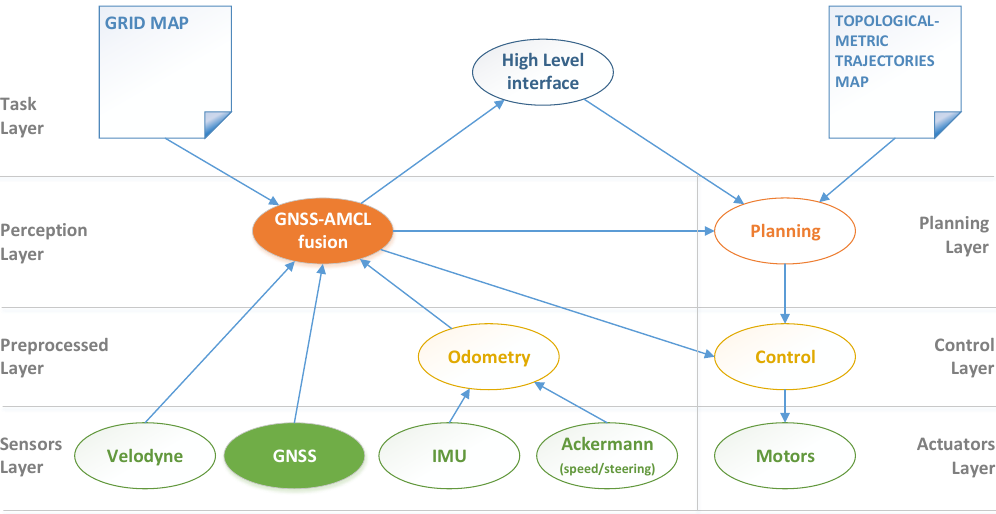
Figure 8. ROS nodes scheme that shows the second implementation of our framework which incorporates our novel GNSS fusion localization algorithm. This new implementation has been completed just substituting the previous localization module and adding the GNSS sensor driver. We show these modifications with solid fill in the nodes added or replaced with respect to Figure